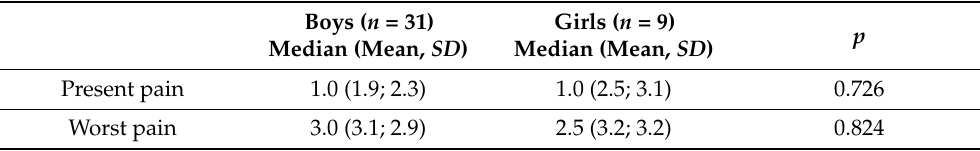
Table 4. Present and worst pain on VAS (range 0–10) for boys and girls with